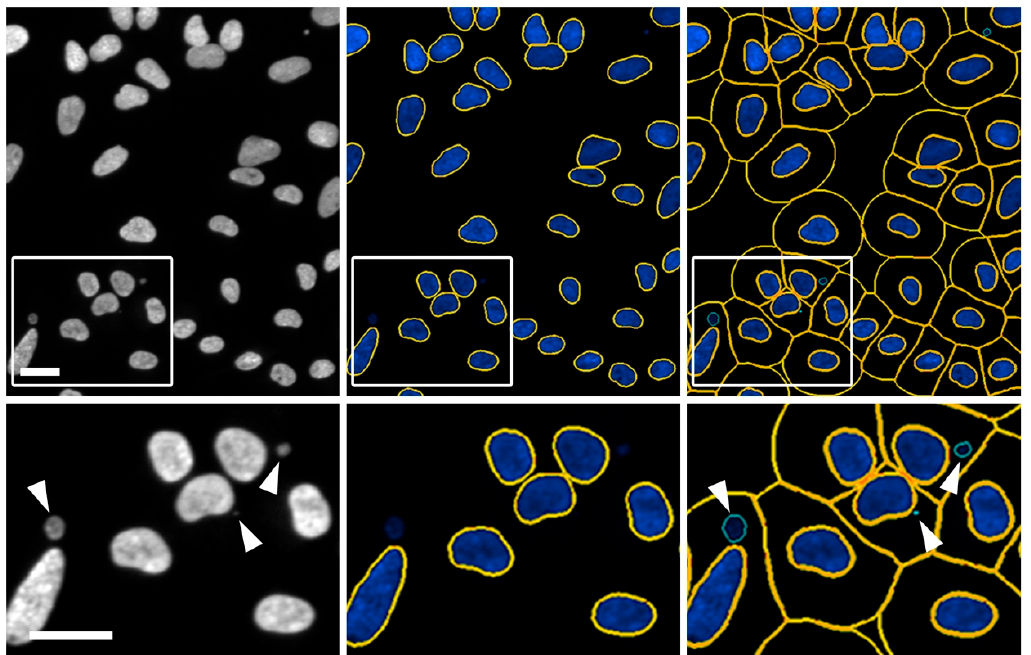
Figure 1. Automated image segmentation and spot detection of micronuclei. Representative images presenting the scQuantIM approach used to detect micronuclei (arrowheads; bottom left image) labelled with Hoechst 33342 in FT246 cells ( SMC1A silenced conditions). Note that only a portion of a 20 × image (i.e., crop image) is presented in the top row, while the bottom row presents the magnified region identified by the bounding box. Gen5 software segments images by applying a primary (nuclear) mask (middle images; yellow lines) and a secondary (cell body) mask (right images; yellow lines), prior to applying spot detection to identify micronuclei (right images; green lines). Scale bar represents 30 μ m.